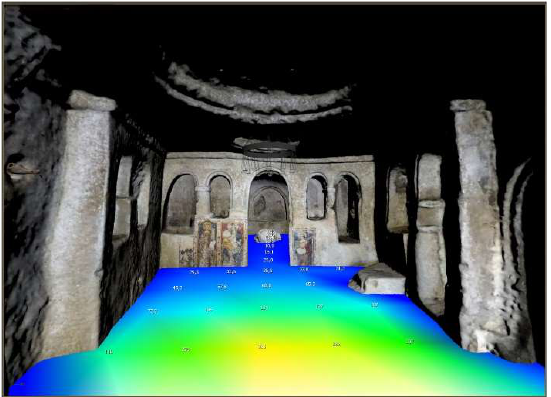
Figure 8: 3D Studio Max Sw, Lightmeter for lighting analysis. Daylight in the nave -h 12.00 - Date: 21 Dec. 2018